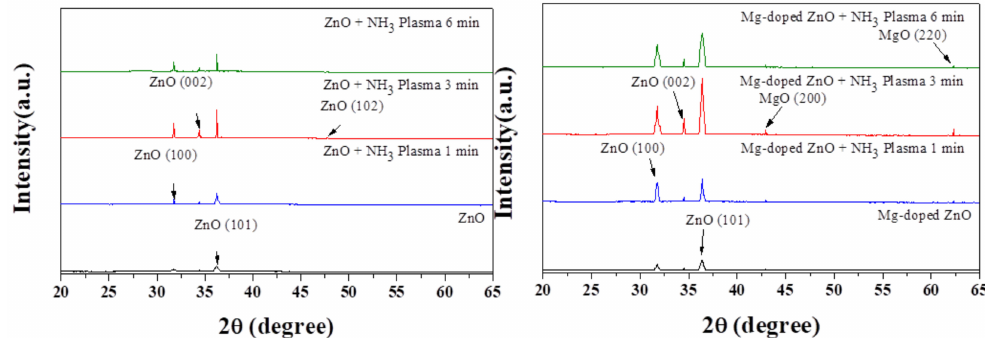
Figure 2. XRD of ZO and MZO film treated with NH 3 plasma on single crystalline silicon for 1 min, 3 min, and 6